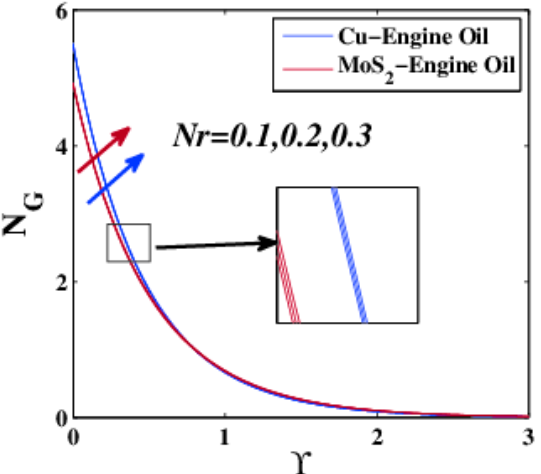
Figure 23. Entropy generation variation 𝑁 (cid:3008) under the influence of 𝑁𝑟 .